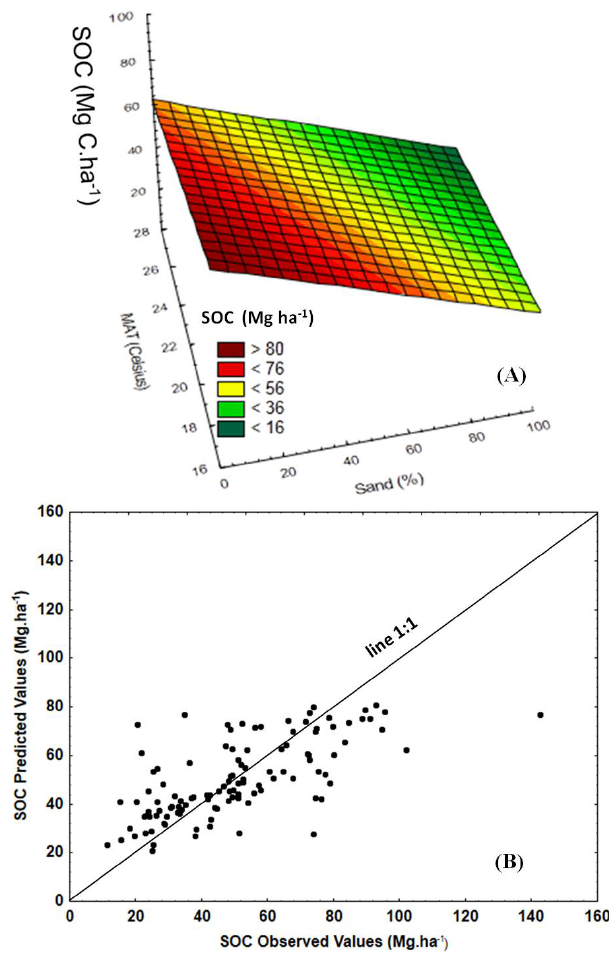
Fig. 7. (A) Tri-dimensional plot of soil carbon stocks at 0–30cm in pasture soils in relation to mean annual temperature (MAT), and sand content (%) according to Eq. (7). (B) Scatter plot of observed soil carbon stocks at 0–30cm in pasture soils compared to predicted soil carbon stocks by Eq.